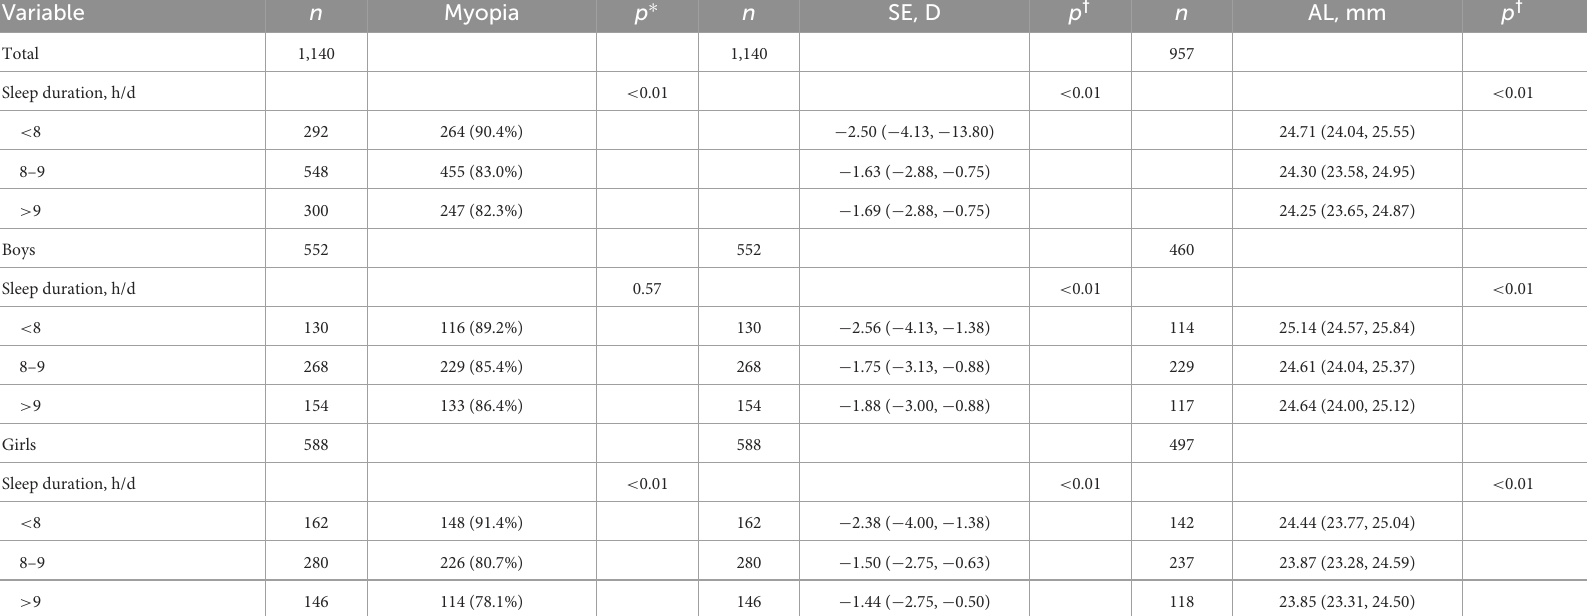
TABLE 2 The spherical equivalent and axial length stratified by sleep duration and gender.